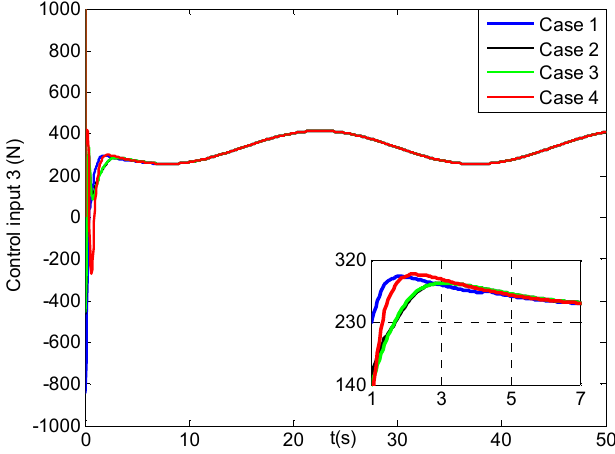
Figure 28. Z direction forces for the third control input of the vehicle (four cases).